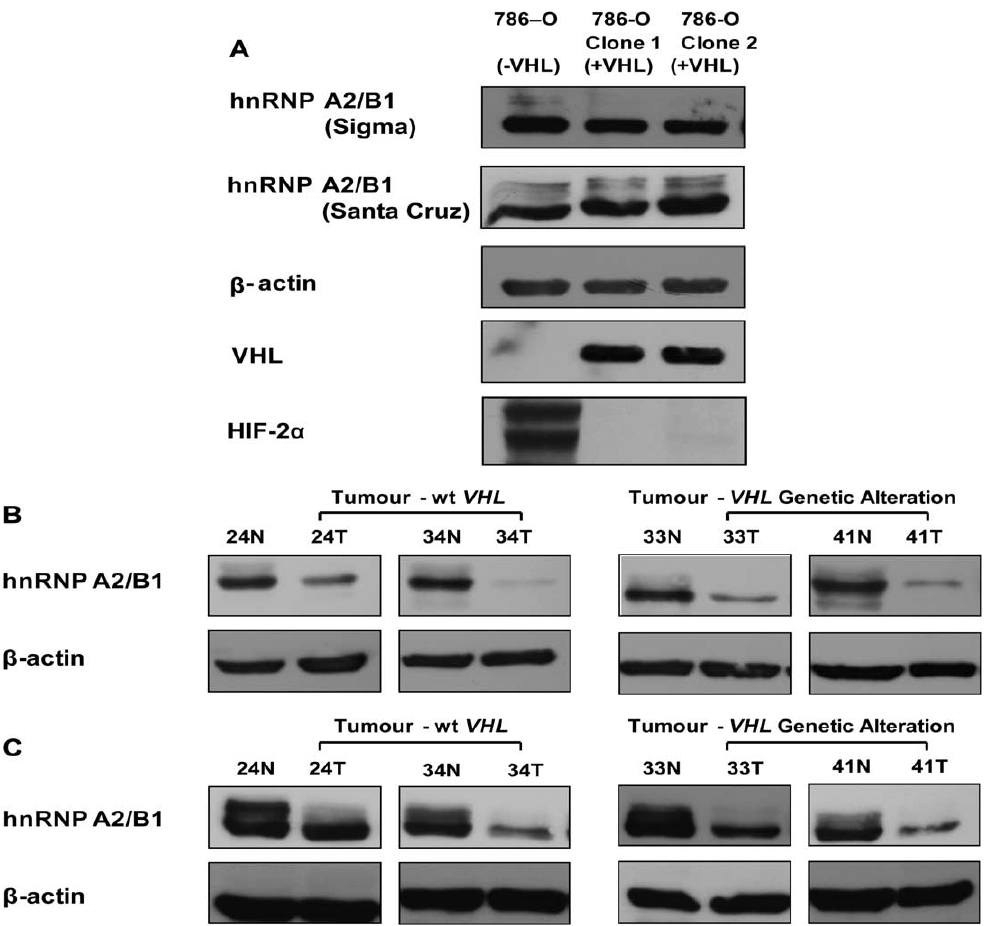
Fig. 3. hnRNP A2/B1 expression in paired normal and tumour CCRCC tissue samples. (A) Western blot analysis of hnRNP A2/B1 expression in whole cell protein lysates prepared from the 786-O cell line ( VHL deficient) and two 786-O VHL cell clones (stably transfected to express pVHL) using two independent hnRNP A2/B1 antibodies. Top panel – clone DP3B3 (Sigma–Aldrich Ltd.); second panel – clone EF-67 (Santa Cruz). The blots were re-probed with anti-VHL and anti-HIF-2 α . Western blot analysis of hnRNP A2/B1 expression in paired normal and tumour lysates using clone DP3B3 anti-hnRNP A2/B1 antibody (B), using clone EF-67 anti-hnRNP A2/B1 antibody (C). VHL genetic alterations were not detected in patients 24 and 34 tumour tissues. VHL mutations were identified in patients 33 and 41 tumour